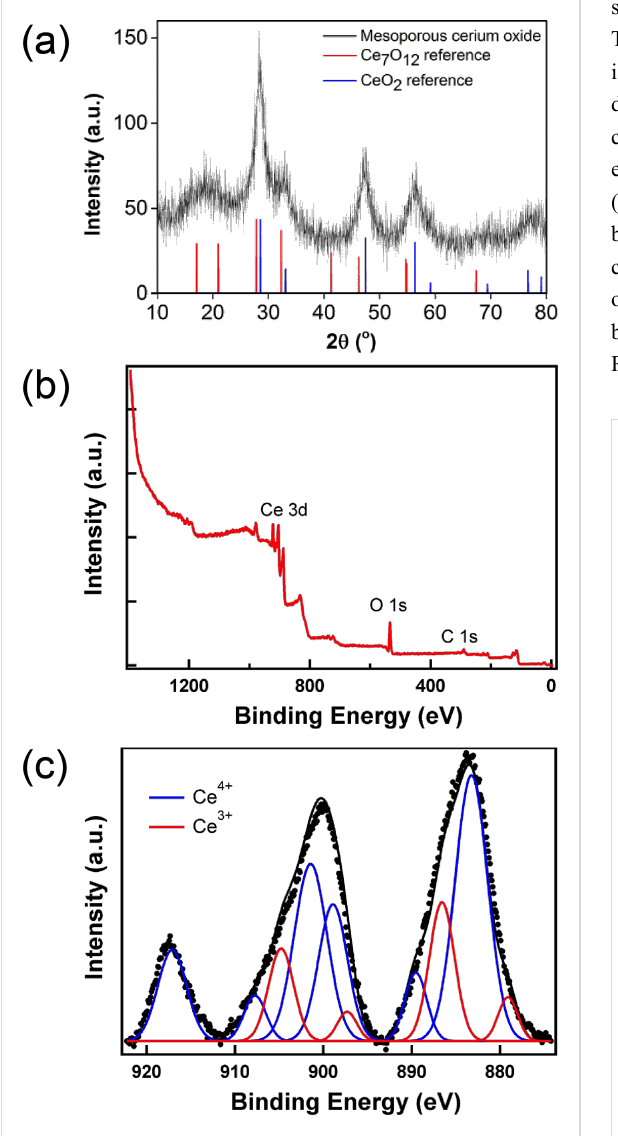
Figure 1: (a) Powder XRD pattern of cerium oxide nanospheres. (b) Wide-scan XPS survey spectrum. (c) High-resolution XPS spec- trum of mesoporous cerium oxide (black circles) with the overall fit (black) and the fits to Ce 4+ (blue) and Ce 3+ (red).